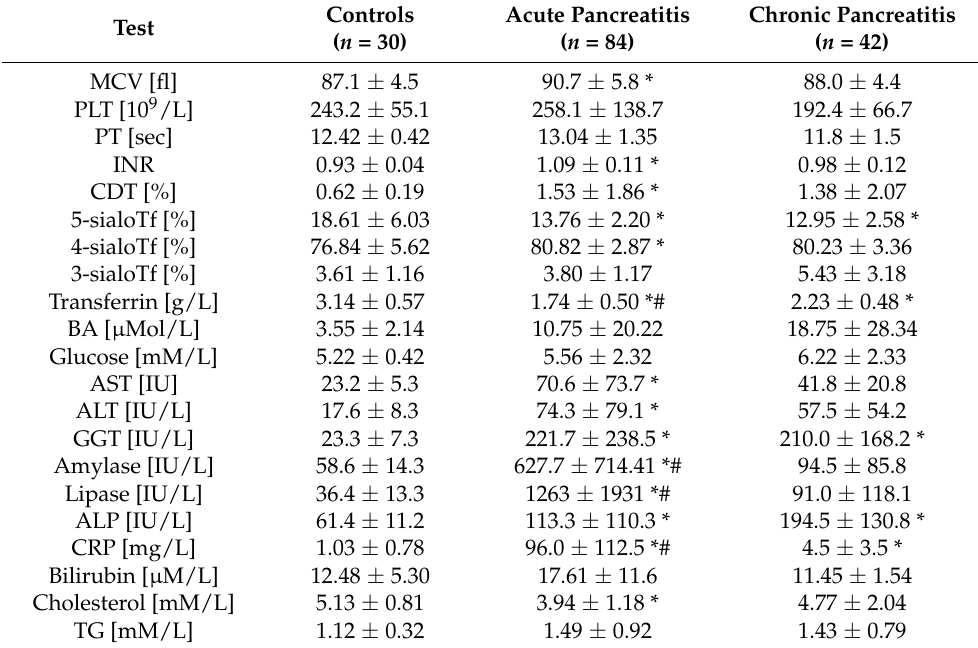
Table 1. The characteristics of the controls and the acute and chronic pancreatitis